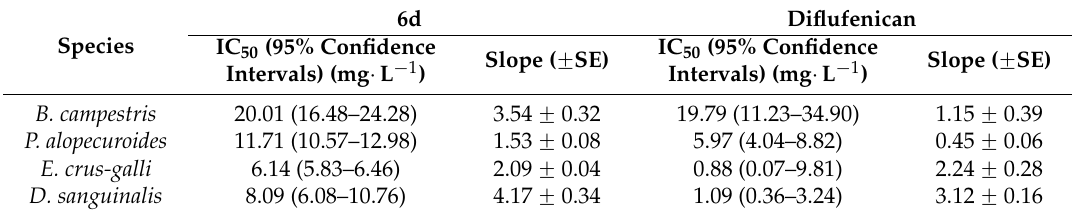
Table 4. Determination of chlorophyll inhibition of compound